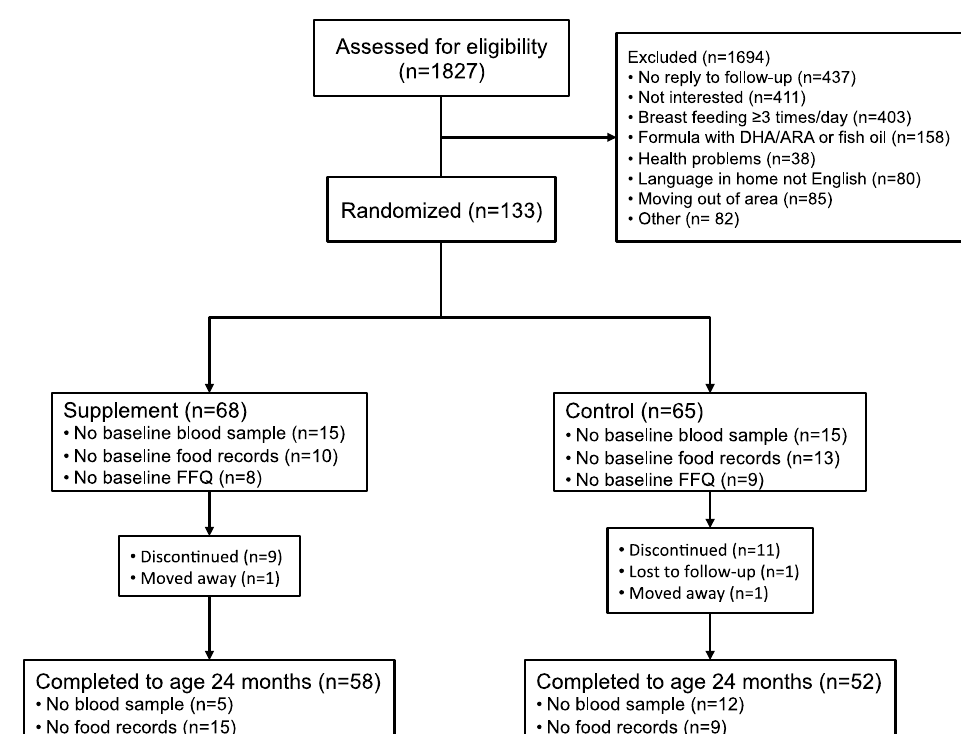
Figure 1. Flow chart illustrating the study subjects in the supplement and control group.